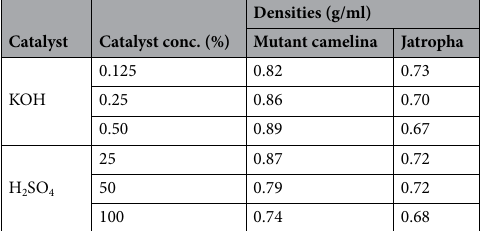
Catalyst Catalyst conc. (%)